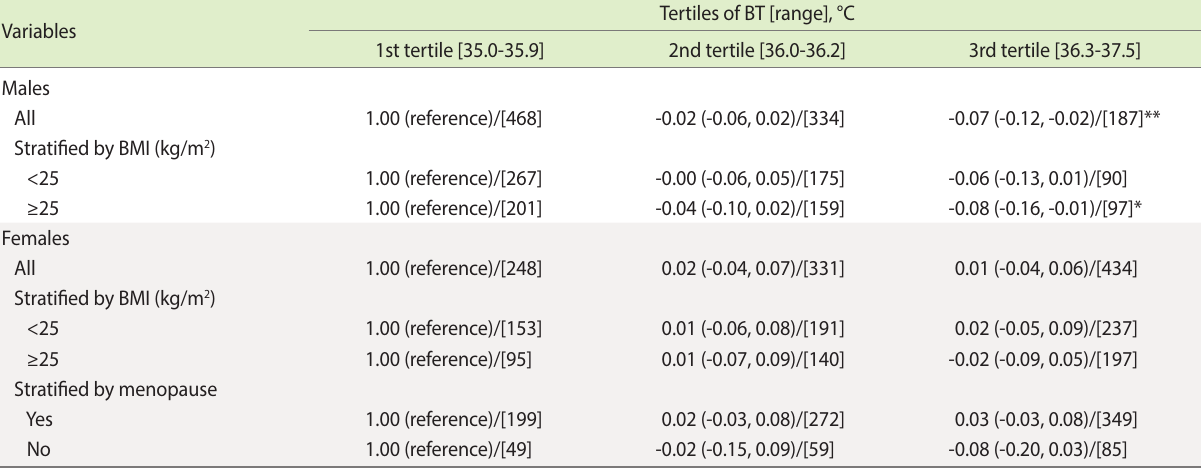
Table 4. Associations between BT and the baseline LTL values by sex and BMI 1